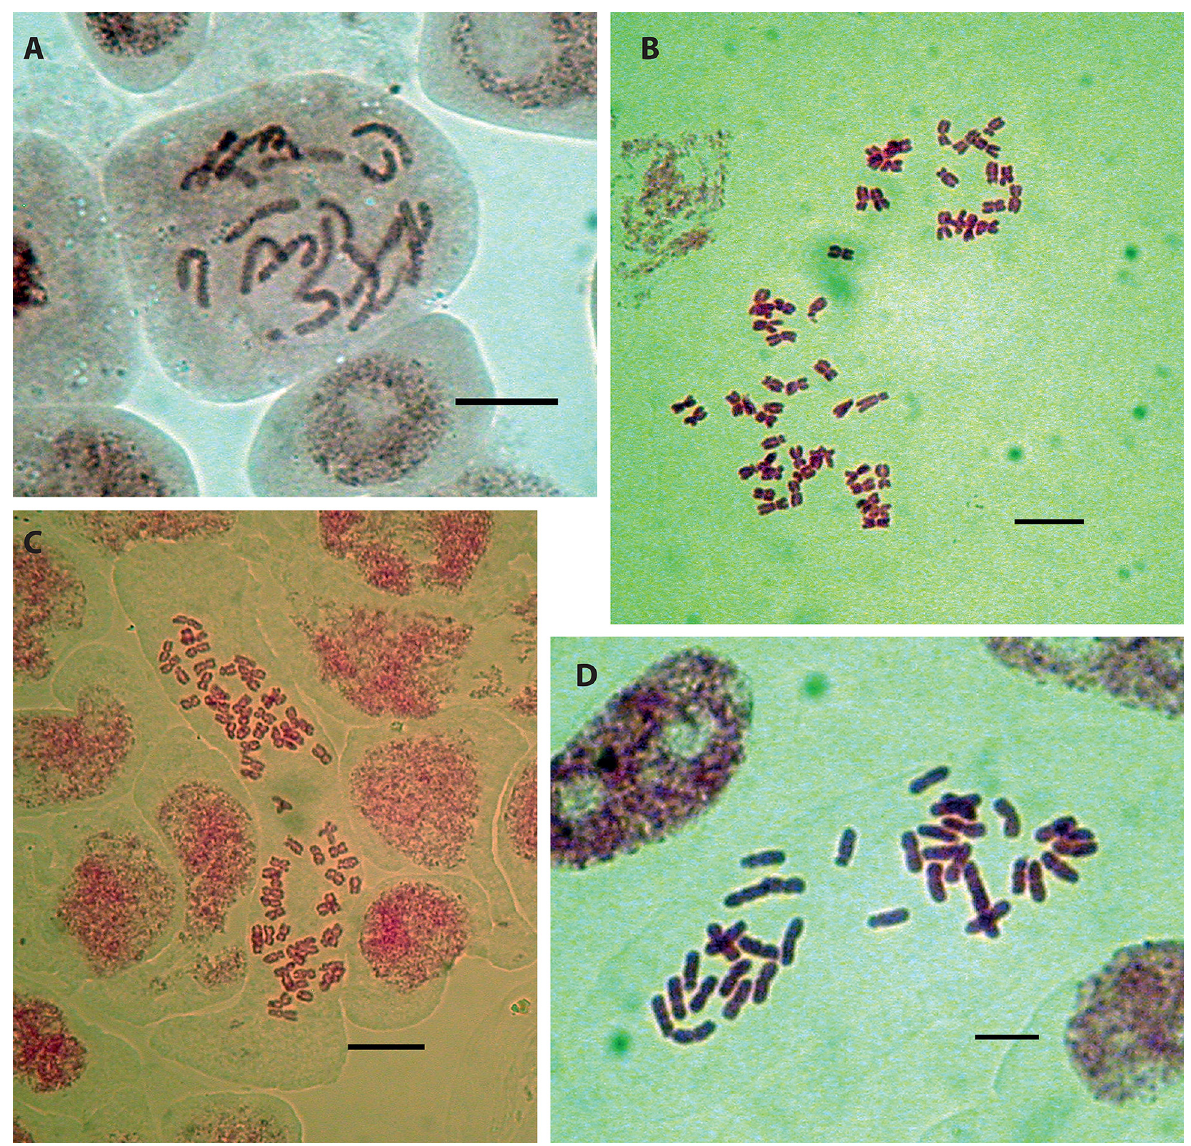
Fig 2. Selected metaphases of the four ploidy levels. A) Diploid plate with 2 n = 18 (pop. Gi1); B) Hexaploid plate with 2 n = 54 (pop. Sa2); C) Octoploid plate with 2 n = 72 (pop. Cs1); D) Tetraploid plate with 2 n = 36 (pop. Pa1). Scale bar = 10 μ